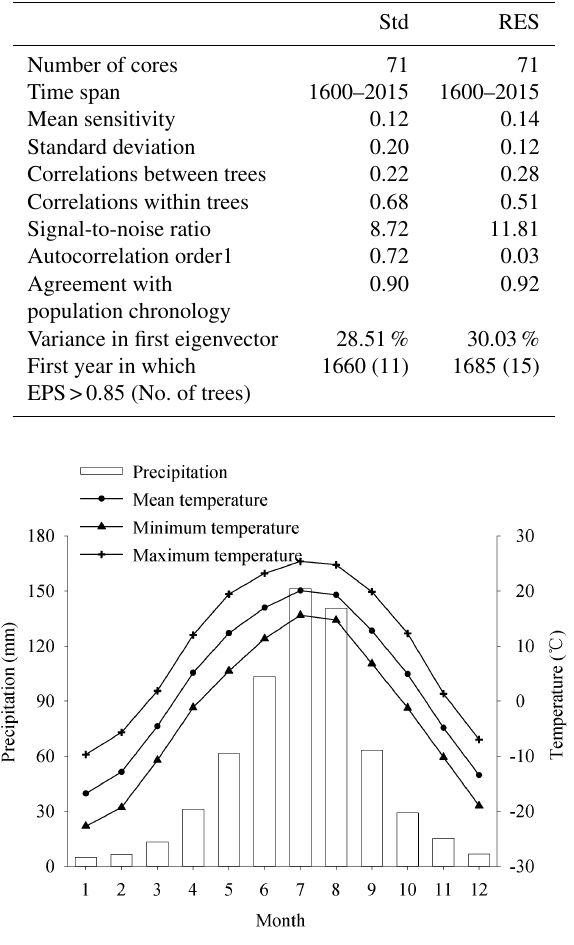
Figure 2. Mean monthly temperature ( ◦ C) and total precipitation (mm) at Dunhua meteorological station for the period from 1956 to 2013.